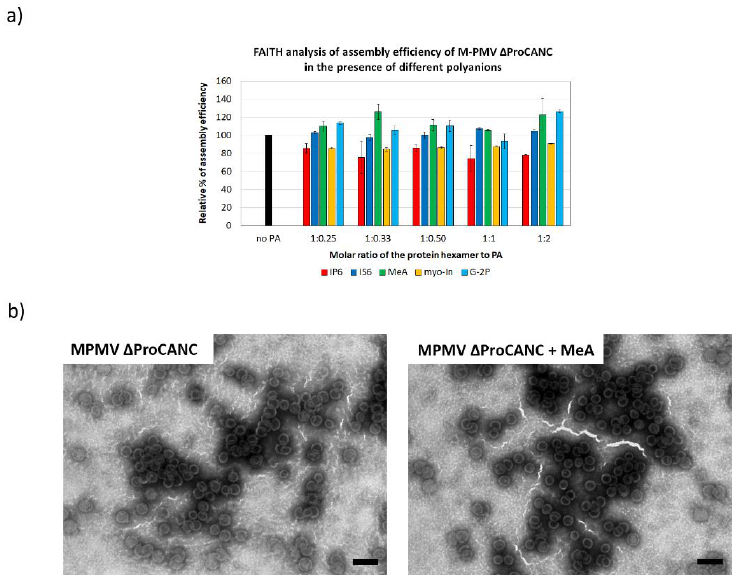
Figure 4. Efficiency of M-PMV ∆ProCANC wt protein assembly in the presence of selected polyanions. ( a ) Percentage of assembly efficiency of M-PMV ∆ProCANC wt protein in the presence of IP6 (red), IS6 (royal blue), MeA (green), myo-In (yellow) and G-2P (azure blue) at indicated protein hexamer to polyanions ratios. ( b ) TEM analysis of negatively stained M-PMV ∆ProCANC wt proteins assembled in the absence ( left ) and presence ( right ) of MeA (the final concentration of MeA was 0.8 µM and the ratio of the protein hexamer to MeA was 1:0.33). Bars represent 200 nm.